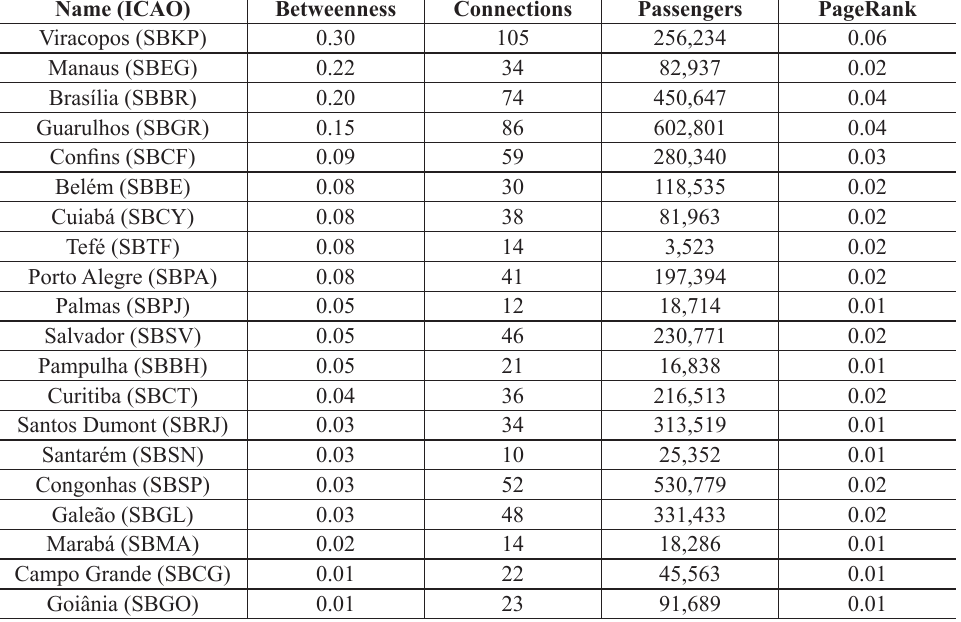
Top-20 Airports - Betweenness Centrality - National